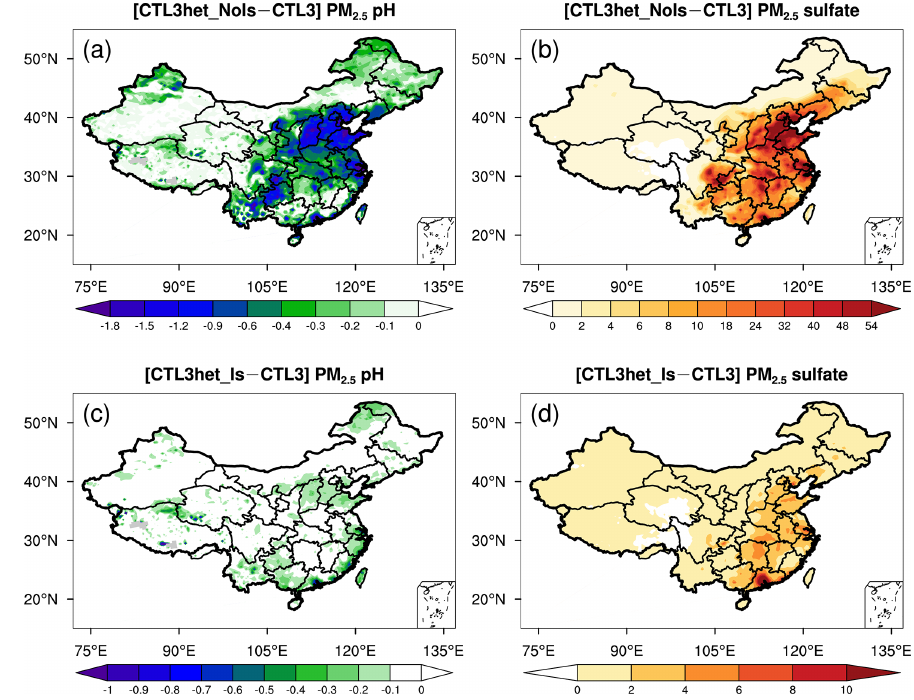
Figure 3. Spatial distributions of the difference in mean surface (a, c) PM 2 . 5 pH and (b, d) PM 2 . 5 sulfate (µgm − 3 ) between CTL3het_NoIs and CTL3 scenarios (top panels) and CTL3het_Is and CTL3 scenarios (bottom panels) during the study period of 15 October–2 Novem- ber 2014. Different scales are used.